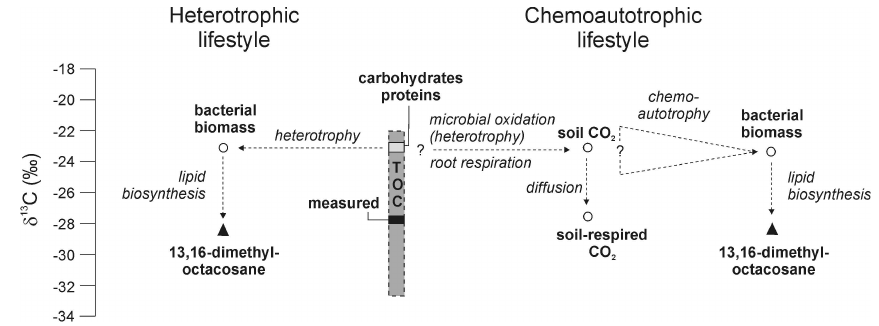
Fig. 4. Simplified schematic representation of the potential heterotrophic metabolism (left hand side) and chemoautotrophic metabolism (right hand side) of the branched GDGT-synthesising bacteria. Filled symbols represent averages of measured values (for the C 3 top-soils), open symbols represent estimated values based on fractionation factors from the